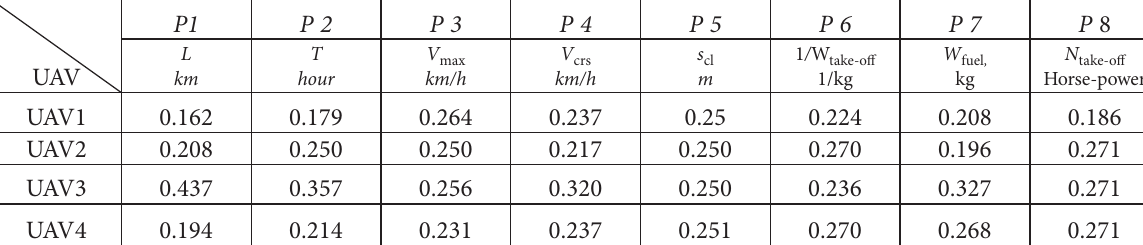
Table 15. Generalised UAV priorities according to IQI-1 Parameter